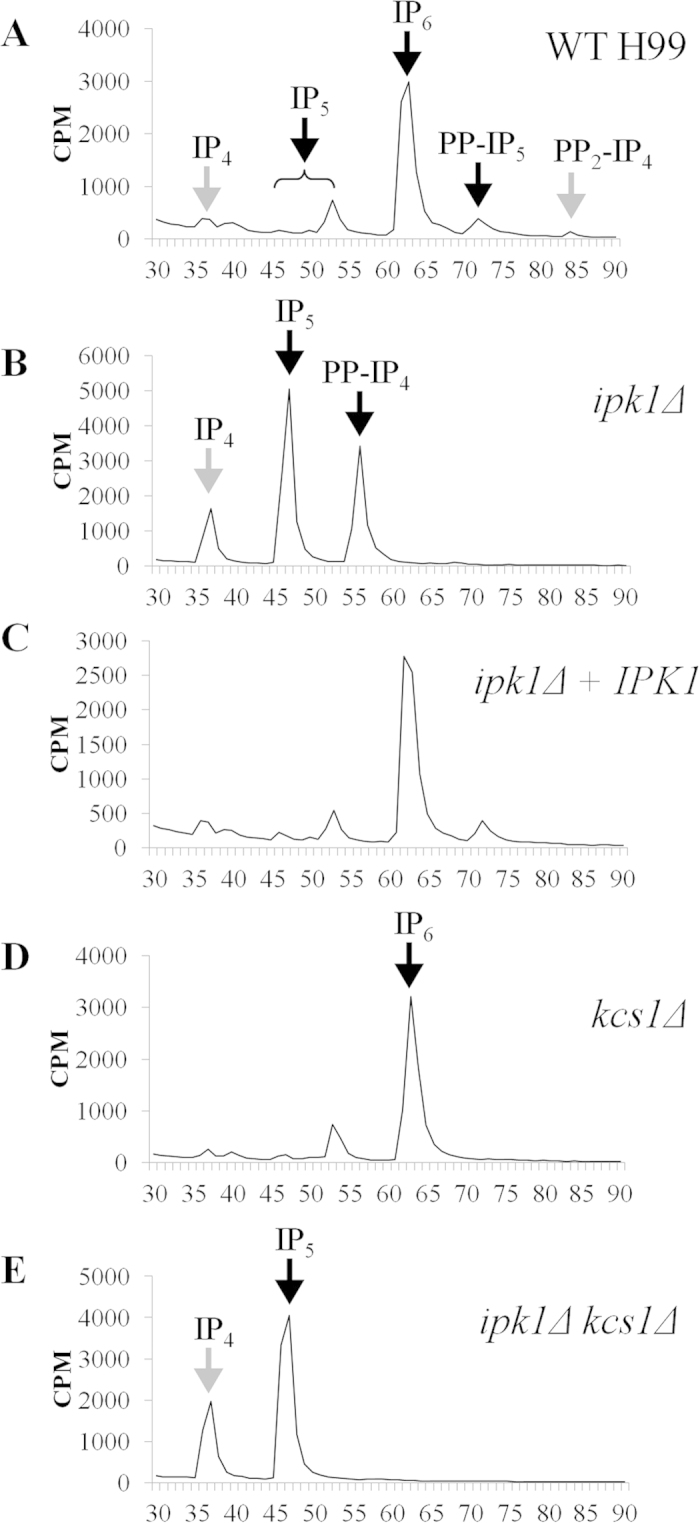
IP profiles of (A) WT, (B) ipk1Δ, (C) ipk1Δ + IPK1, (D) kcs1Δ and (E) ipk1Δ kcs1Δ.Lysates prepared from [3H] myo-inositol-labelled cells were subjected to anion-exchange HPLC analysis. IP species were eluted using a gradient of increasing phosphate concentration. The elution profile of the IP standards used (IP5 isomer [3H]I(1, 3, 4, 5, 6)P5, [3H]IP6, [3H]PP-IP4 and [3H]PP-IP5/IP7) are indicated by the black arrows; grey arrows indicate the expected elution profile of I(1, 3, 4, 5)P4 and (PP)2-IP4/IP8 species.